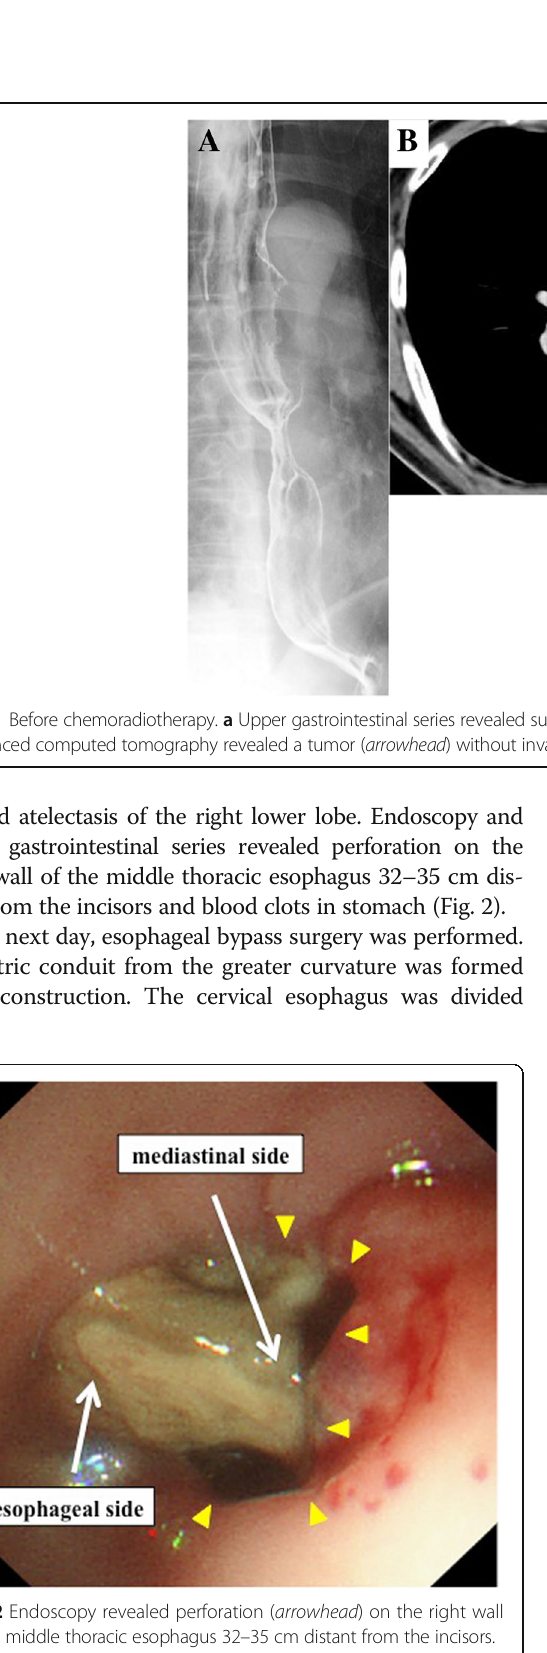
Fig. 3 The patient developed hemoptysis concomitantly with bleeding through the drainage tube inserted into the